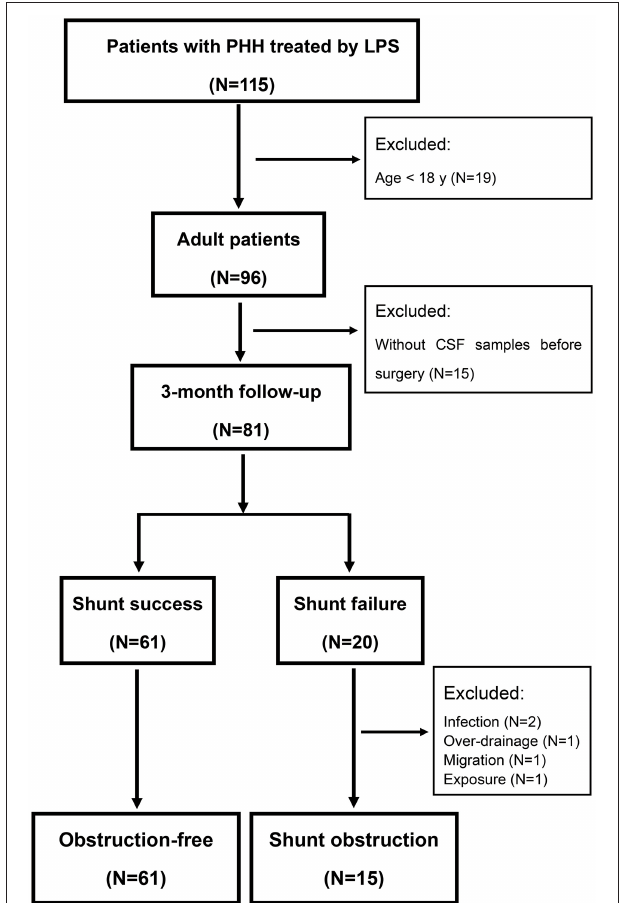
FIGURE 1 | The flowchart of the selection of patients. PHH, post-hemorrhagic hydrocephalus; LPS, lumboperitoneal shunt; CSF, cerebrospinal fluid. Obstruction-free was defined as patients with an improvement of at least one point at NIHSS and without any shunt failure.